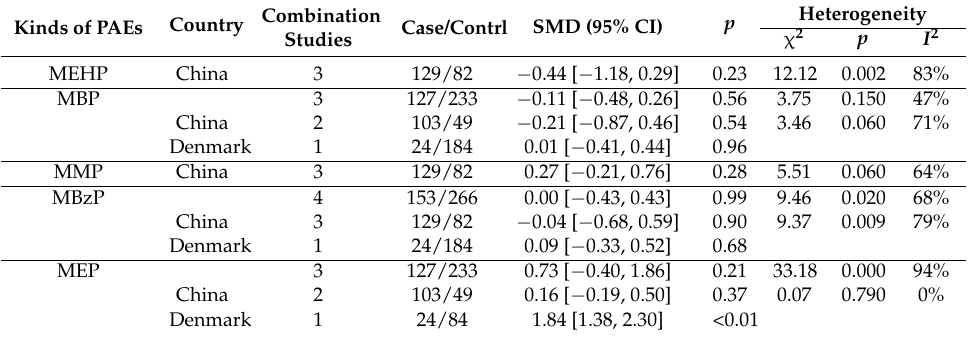
Table 3. Urinary concentration of five PAE metabolites between PP group and Control